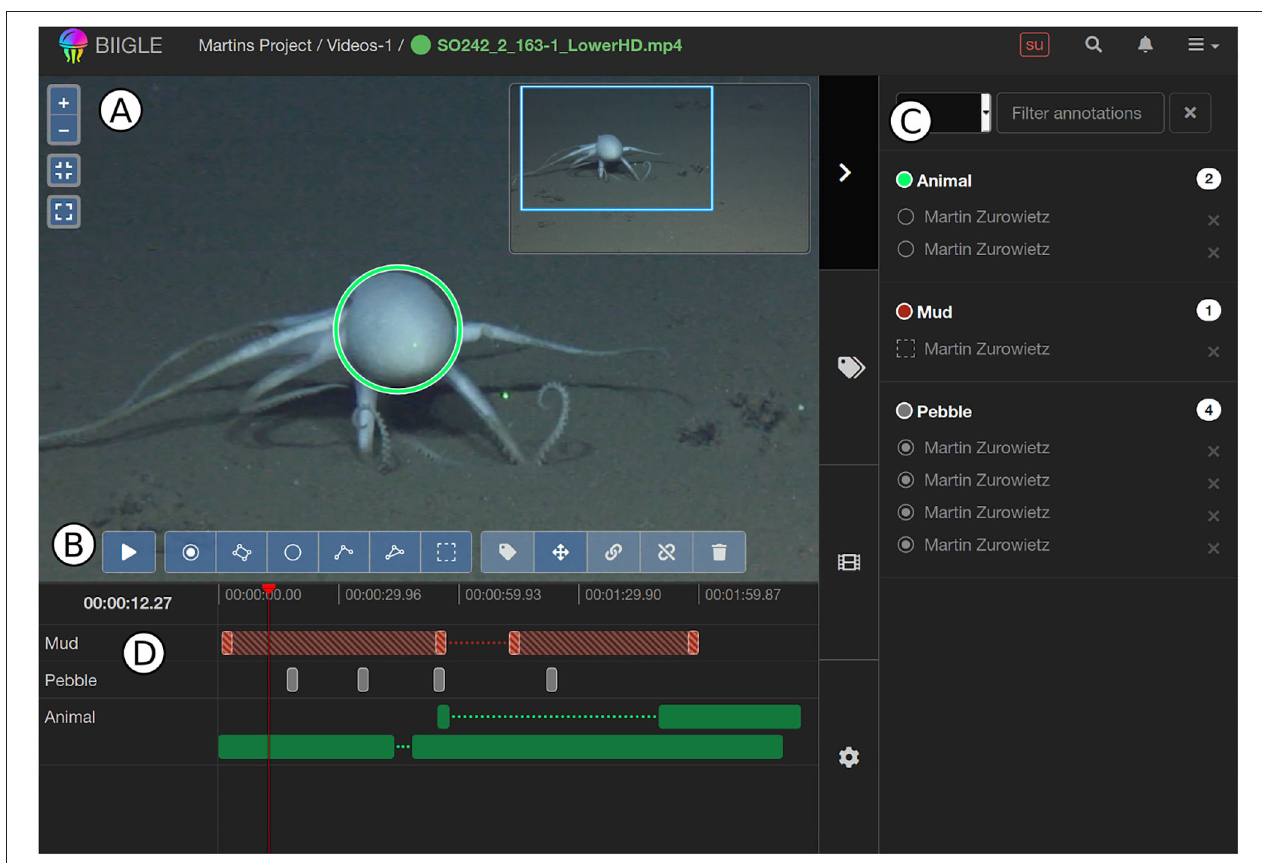
FIGURE 3 | User interface of the BIIGLE video annotation tool: (A) Main display of the video showing the colored outlines of the annotations and the overview minimap. (B) Buttons for video playback and to toggle annotation instruments. (C) Timeline showing the current time of the video as well as indicators for all annotations in the video (indicators for annotations that mark the whole video frame are crosshatched, gaps in annotations are shown as dotted lines). (D) Sidebar with the open tab containing a list of all annotations on the video. Source of the annotated video: (Purser et al., 2016), licensed under CC BY NC 3.0 (https://